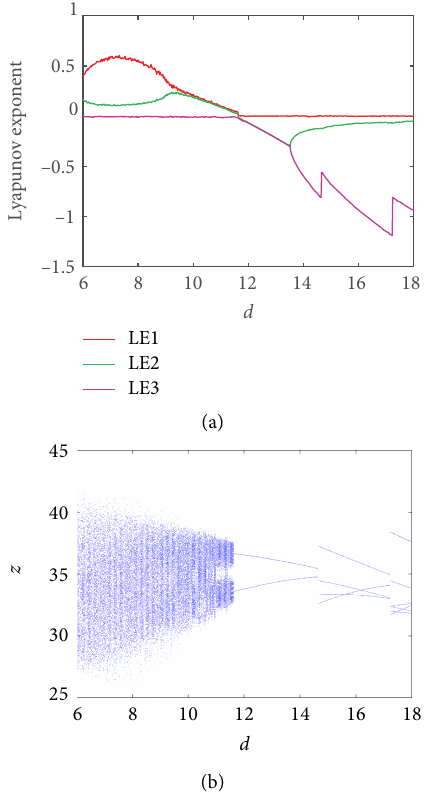
Figure 9: (a) Lyapunov exponent spectrum versus parameter 𝑑 and (b) bifurcation diagram versus parameter 𝑑